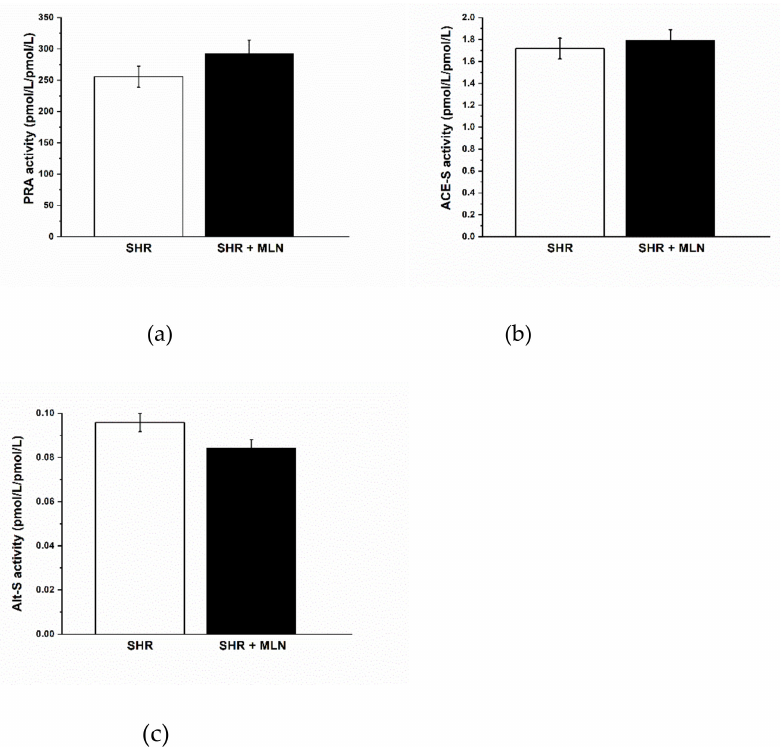
Figure 1. The effect of MLN-4760 treatment on the activity of soluble RAS enzymes determined from angiotensin product/substrate ratios in plasma–plasma renin activity, PRA ( a ); soluble angiotensin converting enzyme, ACE-S ( b ); and the total alternative renin angiotensin system activity, Alt-S ( c ).